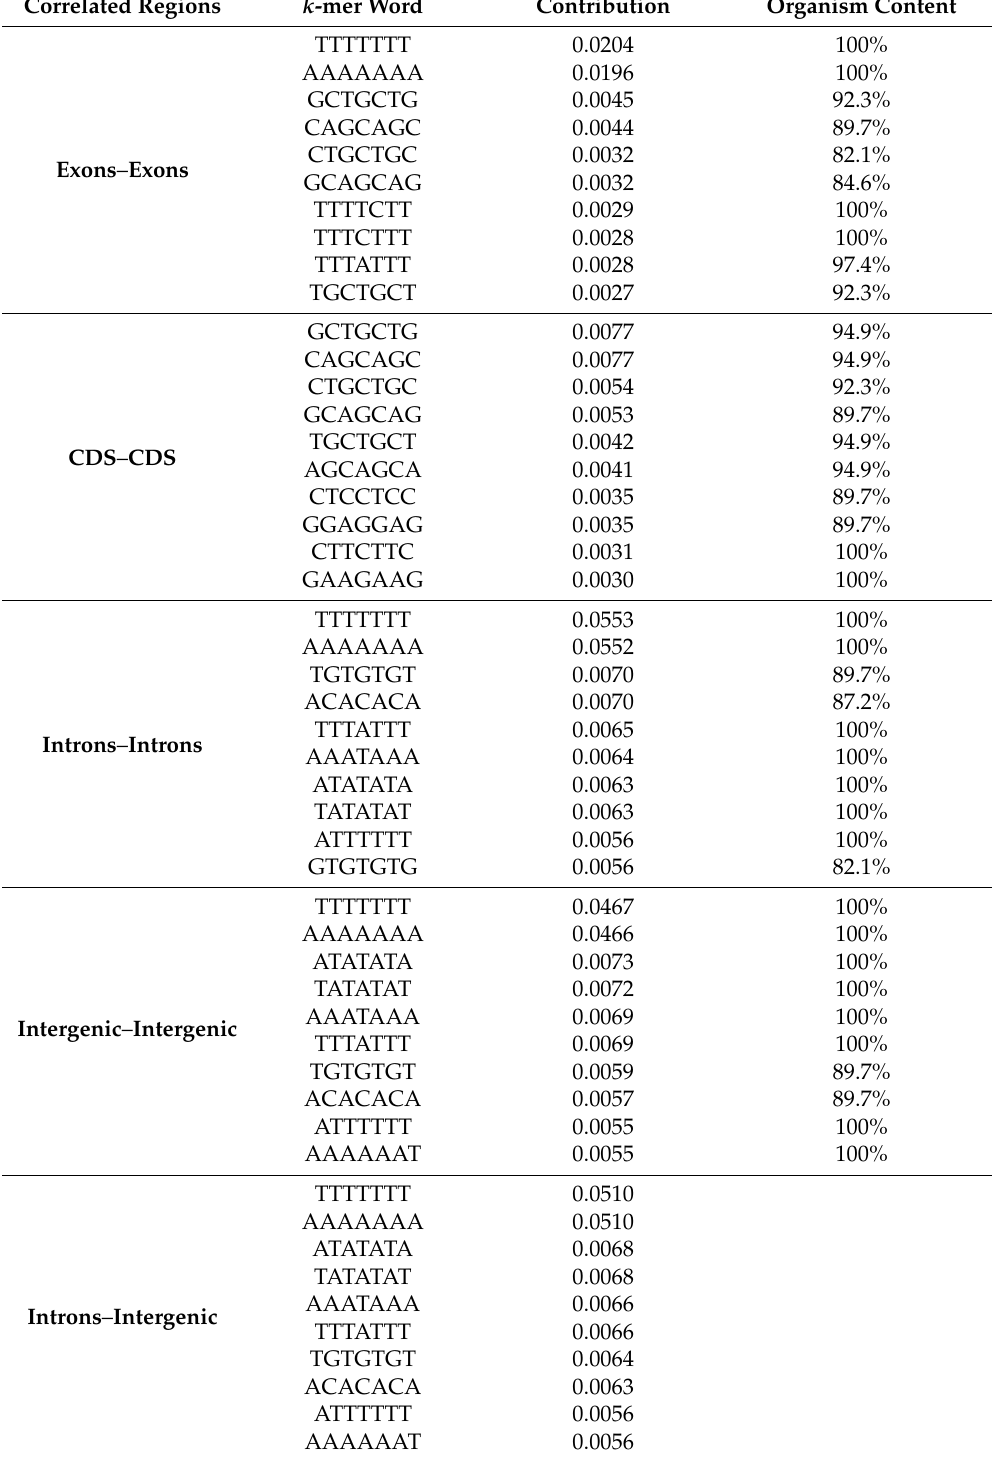
Table 3. List of 10 k -mer words with highest contribution to correlation values for k = 7. Organism Content, shown for homogenous pairings of sequence regions, is defined by the fraction of analyzed organisms for which the difference between content of the corresponding k -mer word and the mean k -mer word content (4 − k ) is larger than 1 σ with respect to the k -mer word content distribution of the respective